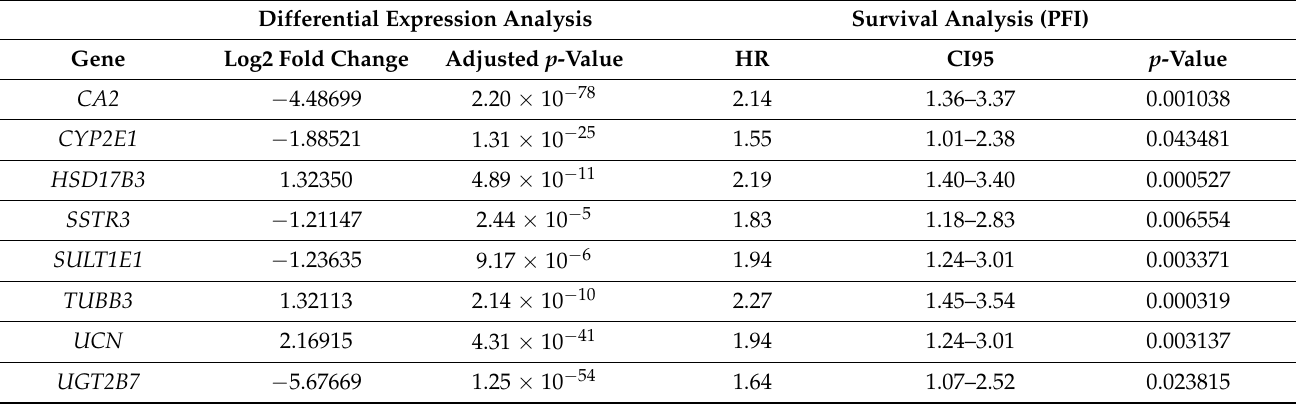
Table 1. The differential expression and hazard ratio (HR) of progression-free interval (PFI). The log 2 fold change and corresponding HR of PFI of each of the 8 genes.